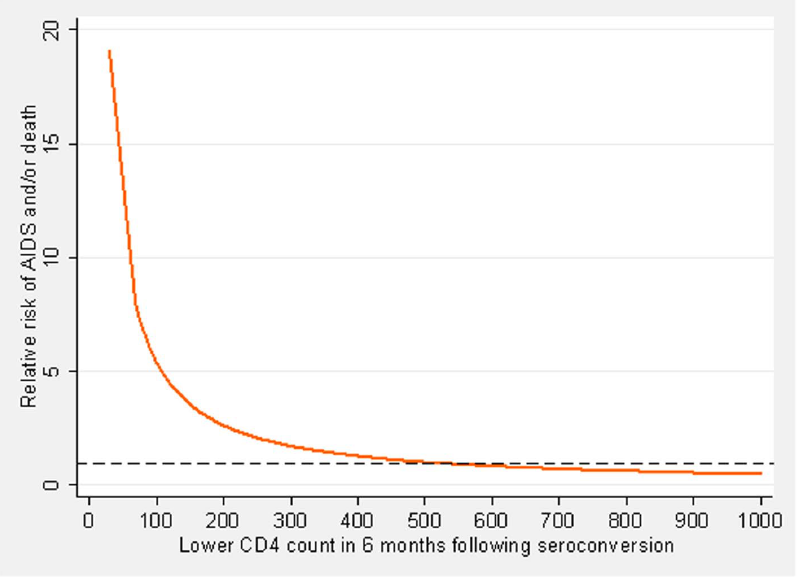
Figure 1. Risk of AIDS and/or death after HIV seroconversion by lowest CD4 count recorded in the first 6 months of HIV diagnosis. The dashed line shows a relative risk of 1 for a CD4 count of 500 cells/mm 3 . Risk adjusted for sex, exposure category and age at HIV seroconversion.